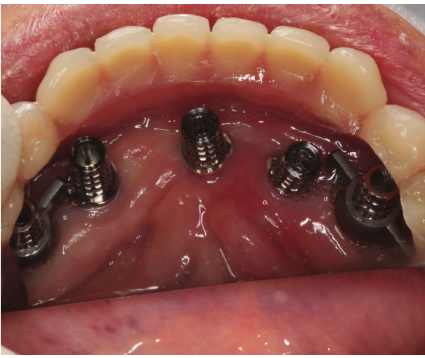
Figure 9: Positioning of the lower denture with titanium cylinders and distal bar.